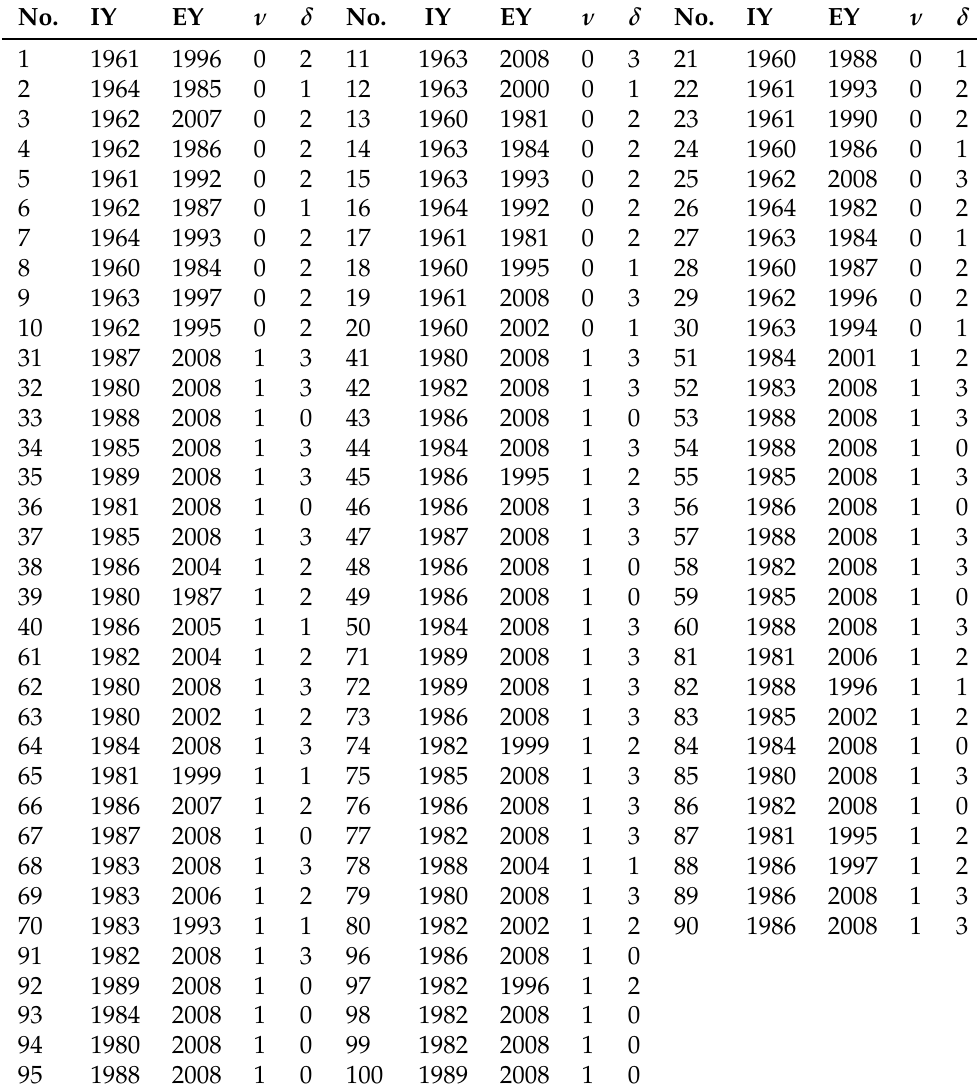
Table 5. LTRC transformers’ competing risks data with partially observed failure